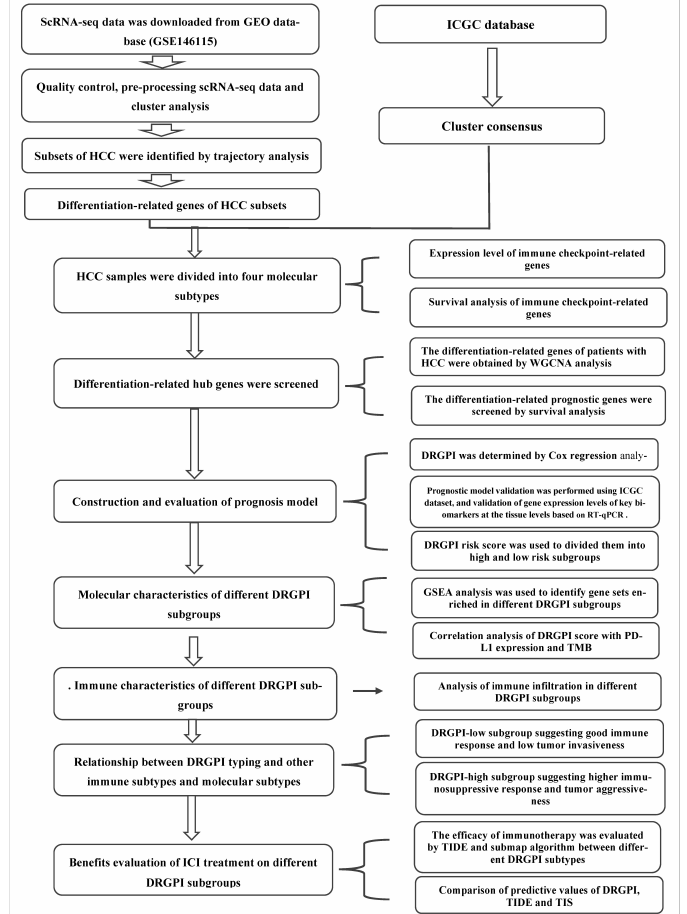
Figure 1. The flow sheet of this